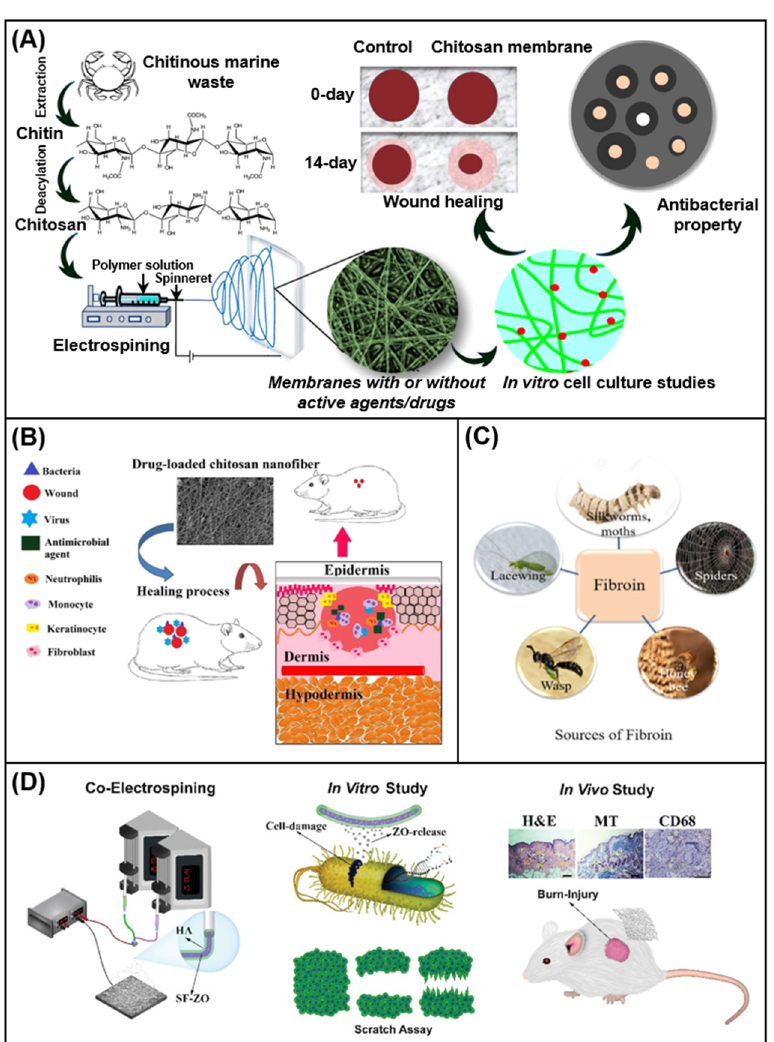
Figure 5. ( A ) Chitosan extracted from natural sources and developed into electrospun fiber mem- branes and its application in wound healing [34]; ( B ) a schematic diagram of the wound healing process of a drug-loaded chitosan dressing [103]; ( C ) the sources of fibroin [107]; ( D ) preparation and in vitro and in vivo study of HA/SF-ZO nanofiber by coaxial electrospinning [108].